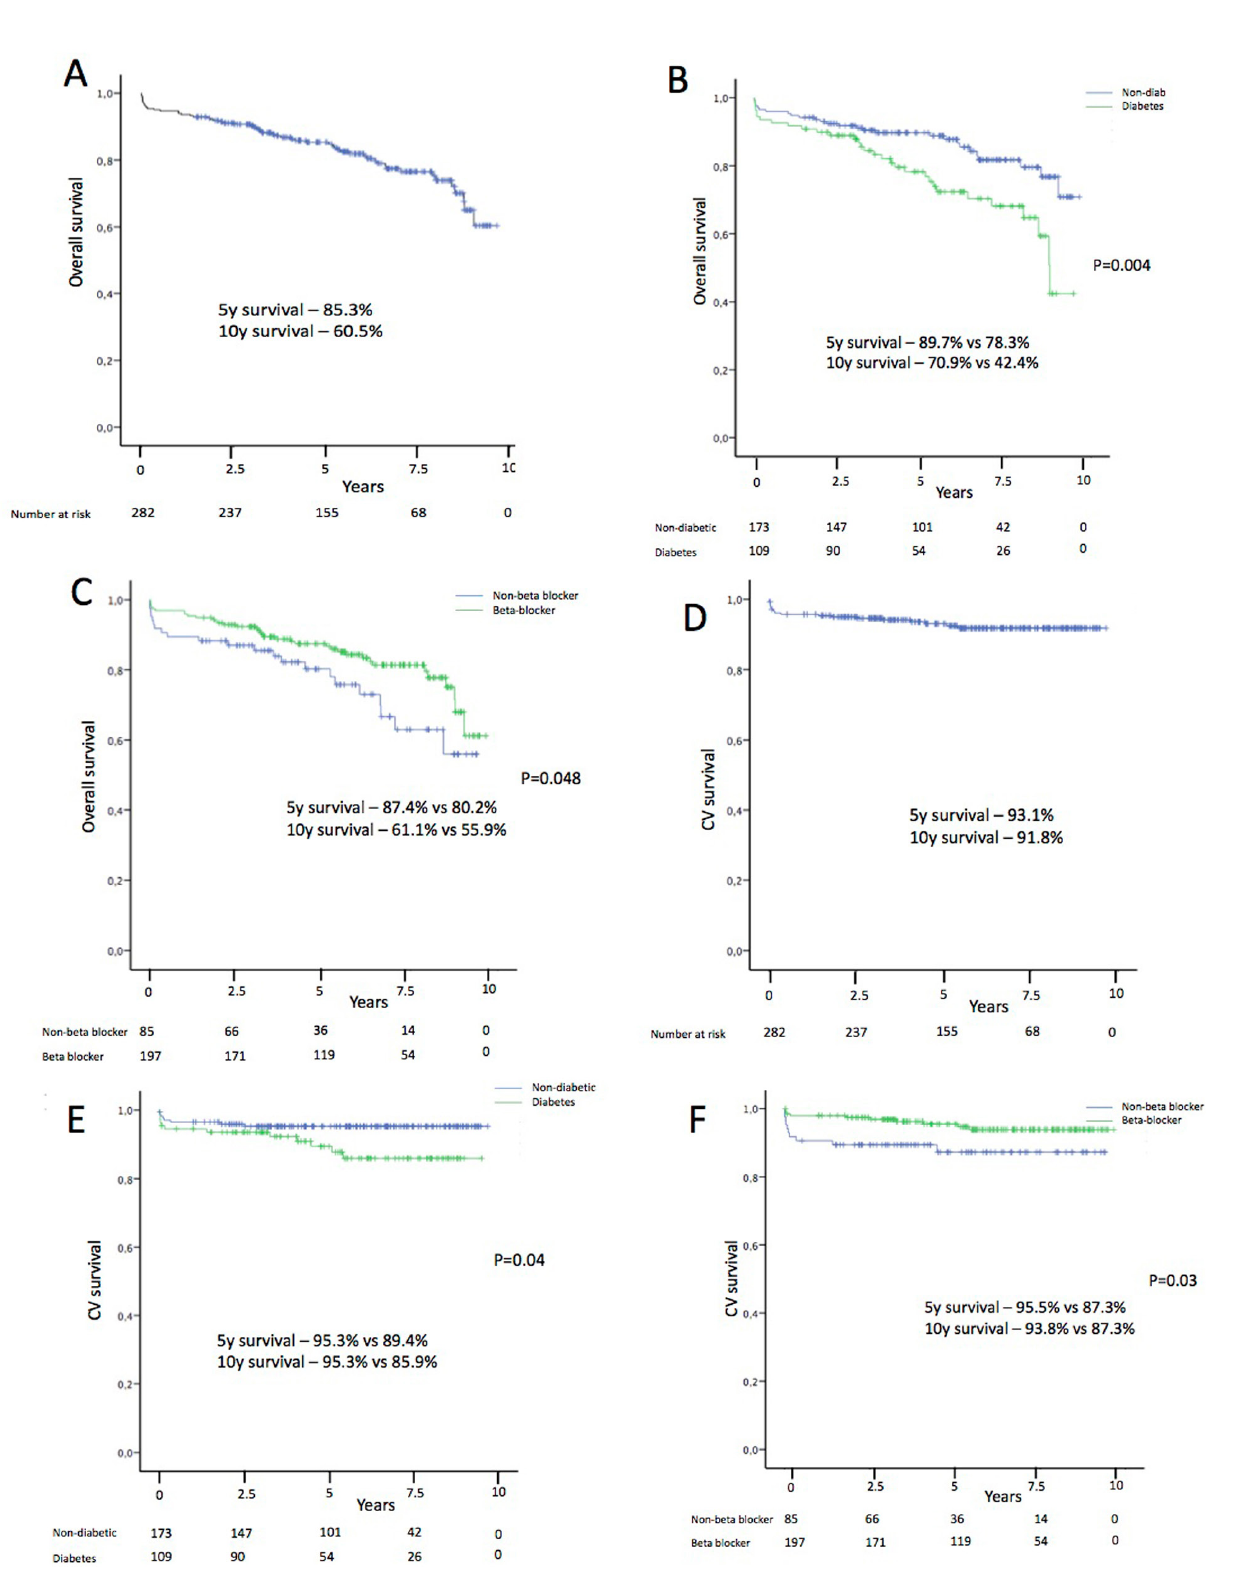
Fig. 1 – Survival of patients with stable angina after coronary artery bypass grafts (CABG). Overall survival (A, B, and C) and cardiovascular (CV) survival (D, E, and F). Global population (A and D), diabetic and non-diabetic patients (B and E), with beta-blocker and without beta-blocker treatment before surgery (C and